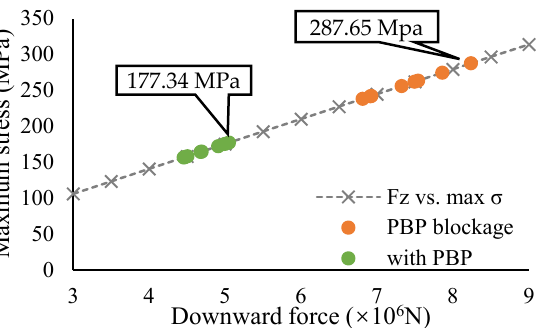
Figure 12. The equivalent stress distribution of support bracket at maximum axial force ( C φ = 0.0142) with PBP blockage.